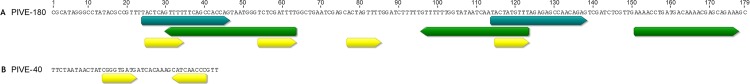
Consensus sequence of monomeric units.Consensus of PIVE-180 (A) and PIVE-40 (B), showing direct repeats (green), inverted repeats (blue), and short repeats (yellow).